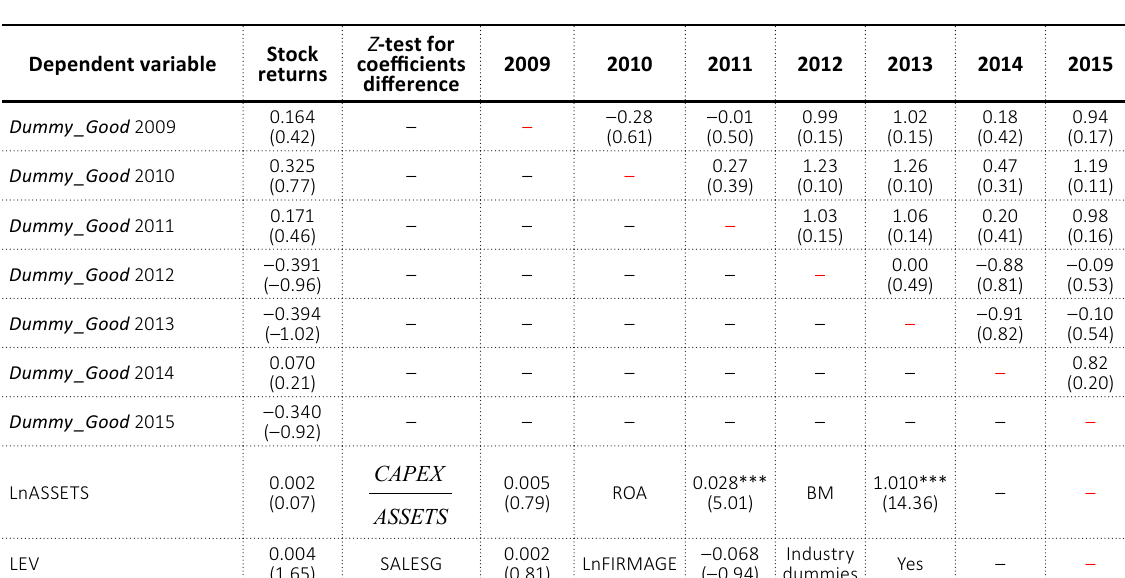
Table 4 (cont.). Fixed effects regression of stock returns on corporate governance by dummy variables with industry dummy